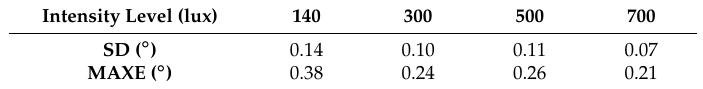
Figure 8. ( a ) AOP accuracy after calibration under different polarized light-intensity levels; ( b ) Comparison of SD of AOP error before and after calibration. Table 1. Statistics comparison of AOP error under di ff erent light-intensity levels.